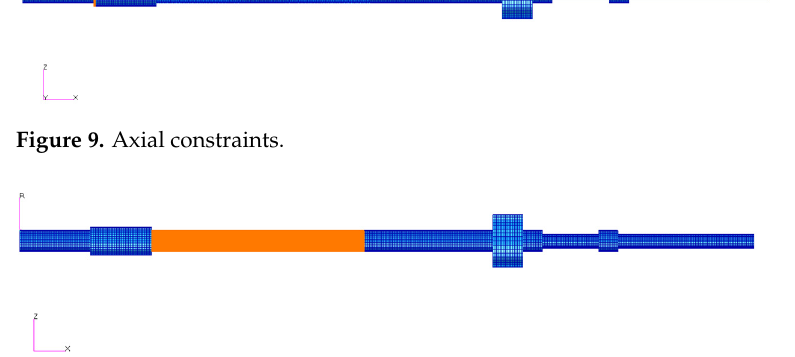
Figure 10. Torque constraints.